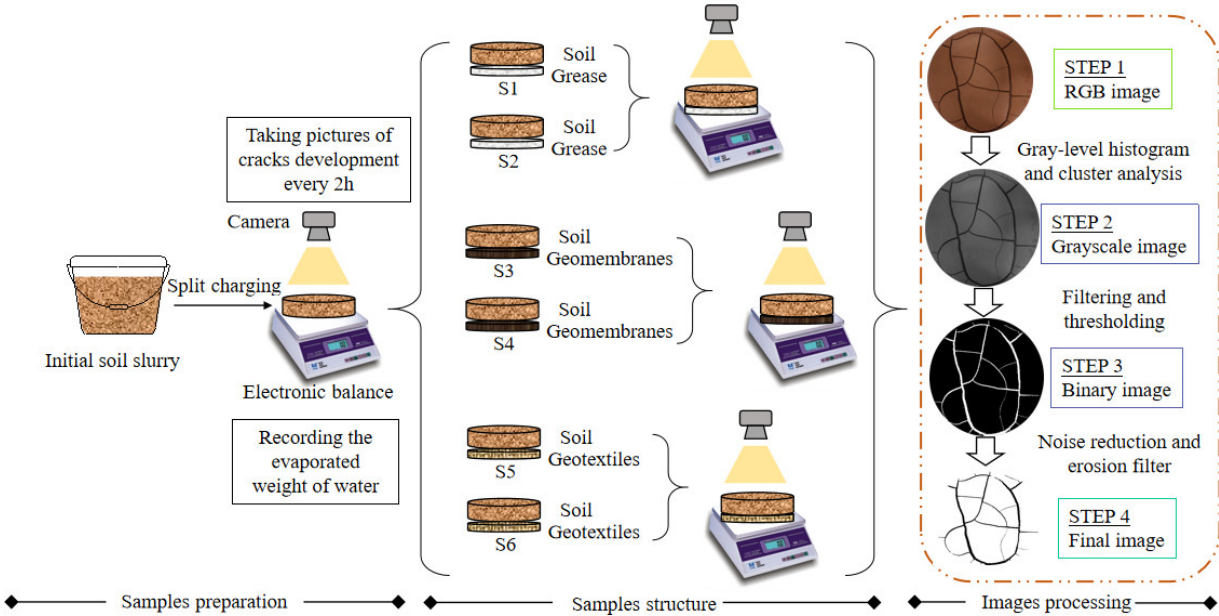
Figure 1. Schematic view of the testing procedure and image processing. Table 1. The parameters of each group of specimens. Table 1. The parameters of each group of specimens. Specimen